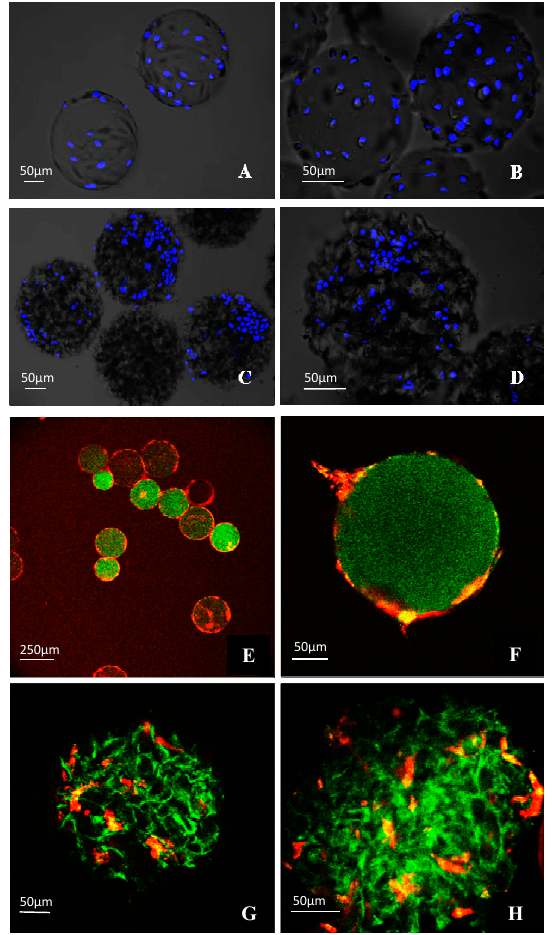
Figure 6. Fluorescence microscopy ( A–D ) and two-photon microscopy images ( E–H ) of DPSCs grown on microcarriers. ( A – D ): cell nuclei visualized by fluorescence microscopy after DAPI staining. ( E – H ): Vybrant DiD pre-stained cells on the microspheres using two-photon microscopy. ( A , B , E , F ): Cytodex 1. ( C , D , G , H ): Cytopore 2. The scale bar indicates 50 µ m or 250 µ m ( E